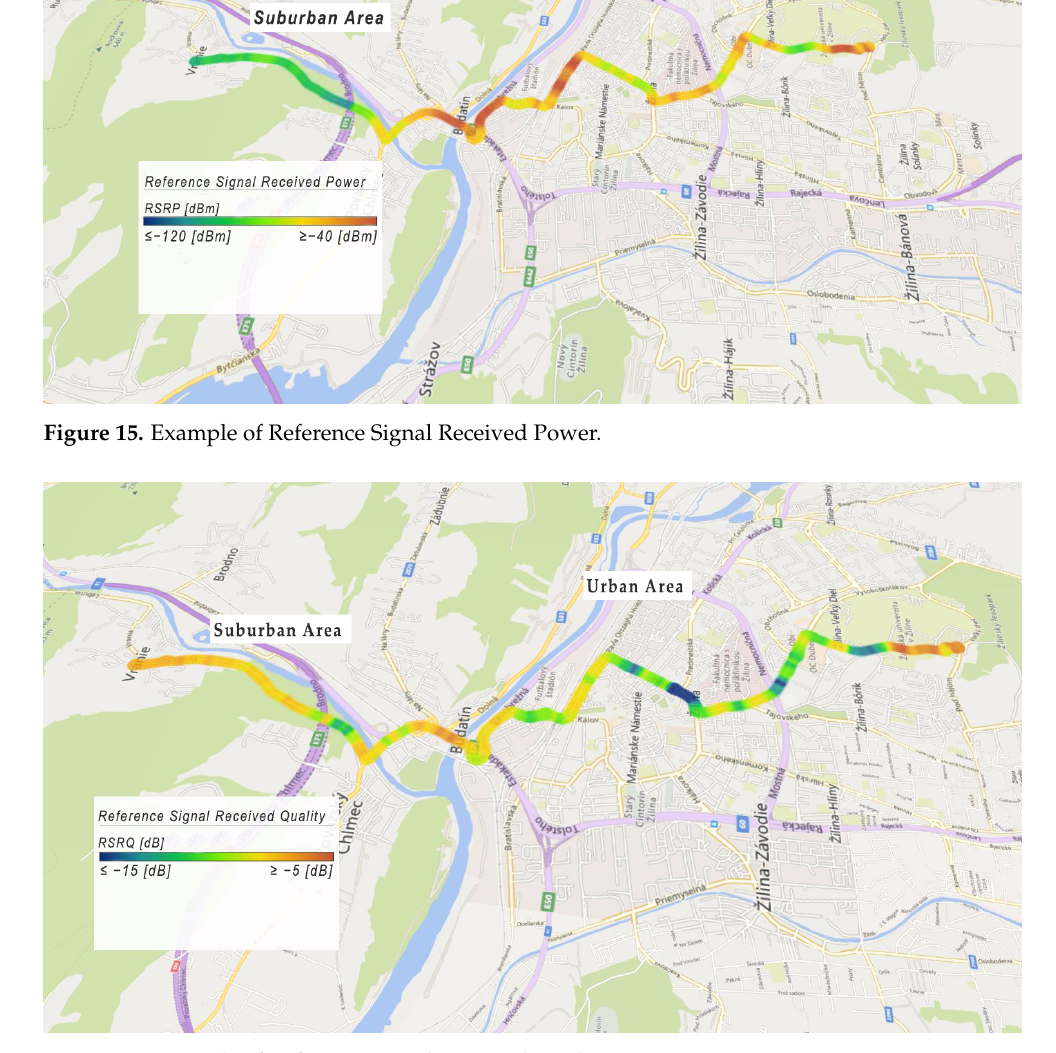
Figure 16. Example of Reference Signal Received